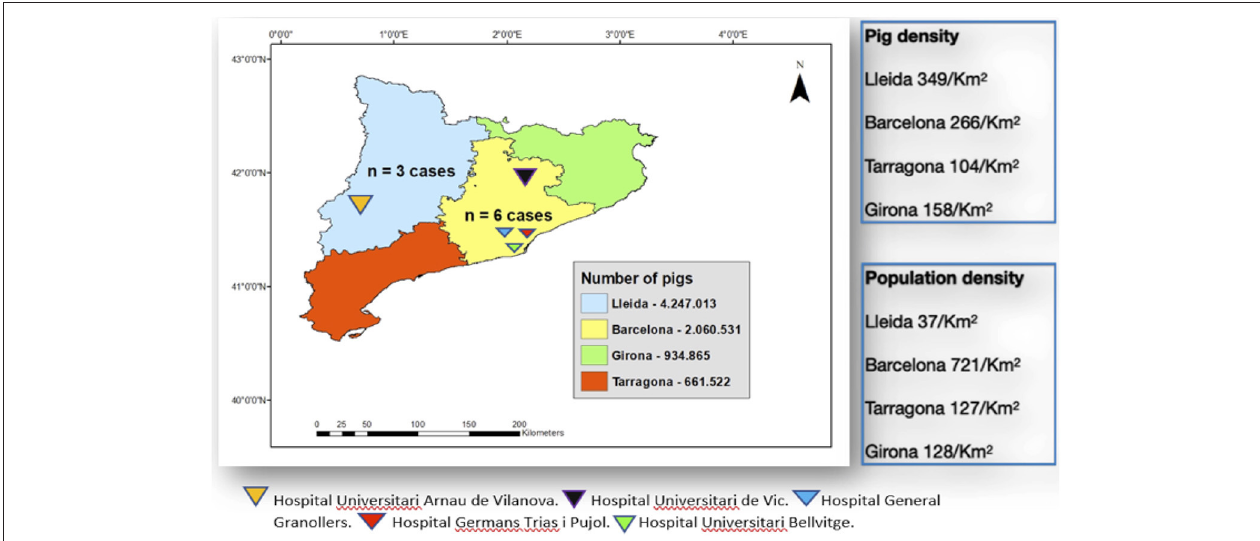
FIGURE 1 | Map of the autonomous region of Catalonia in Spain showing the number of S. suis invasive infections, the density of pigs/km 2 and the population/km 2 by province.